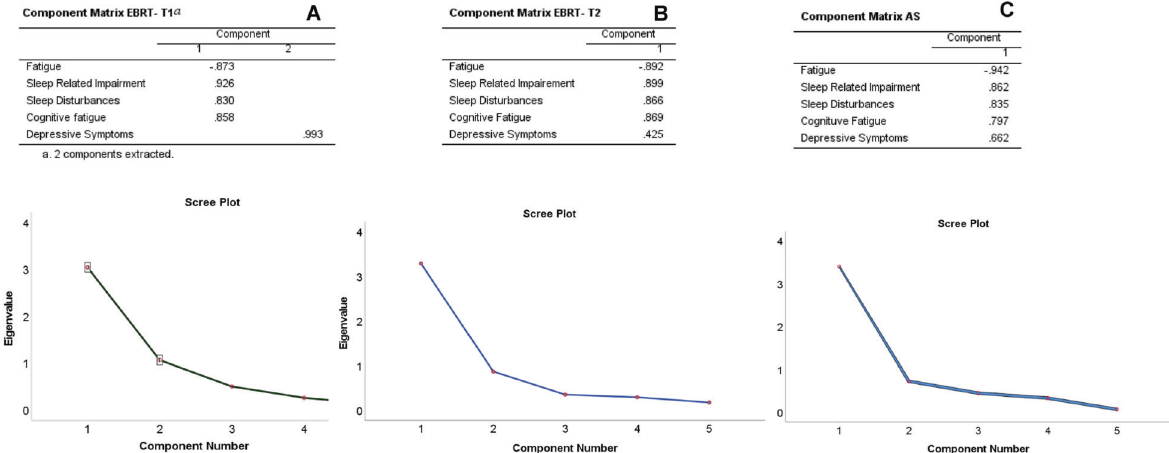
Fig. 2 Principal component analysis results. A Two components were extracted, component 1 had an initial eigenvalue of 3.05 with 60.9% of variance and component 2 had an initial eigenvalue of 1.01 with 21% of variance demonstrated by scree plot. Component 2 did not meet clinical de fi nition for symptom cluster [25]; thus, only component 1 is included. Assumptions for PCA met: KMO for sampling adequacy (0.676) and Bartlett ’ s test Chi square for suitability for data reduction (92.8, p < 0.0001). B One component was identi fi ed for EBRT-T2 cluster with an initial eigenvalue of 3.3 and 65.8% of total variance. The corresponding scree plot illustrates the component. Assumptions met included KMO for sampling adequacy (0.82) and Bartlett ’ s test Chi square for suitability for data reduction (102.9, p < 0.0001). C One component was